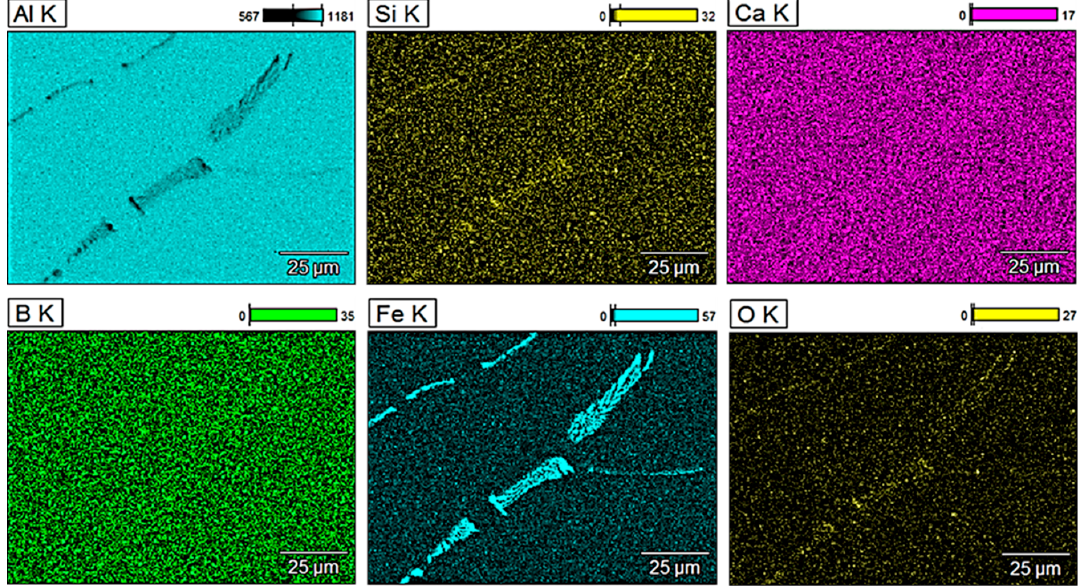
Figure 3. Energy-dispersive X-ray (EDX) mapping of EN AW 1370 (metallurgical synthesis).